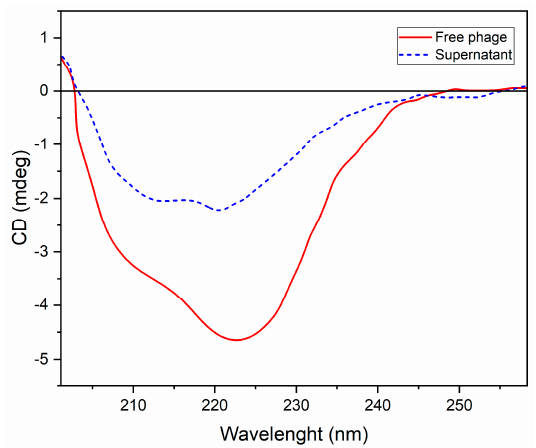
Figure 8. A Circular dichroism (CD) spectrum of free bacteriophage (red spectrum) and bacteriophage released from post-encapsulated MPs (blue spectrum).